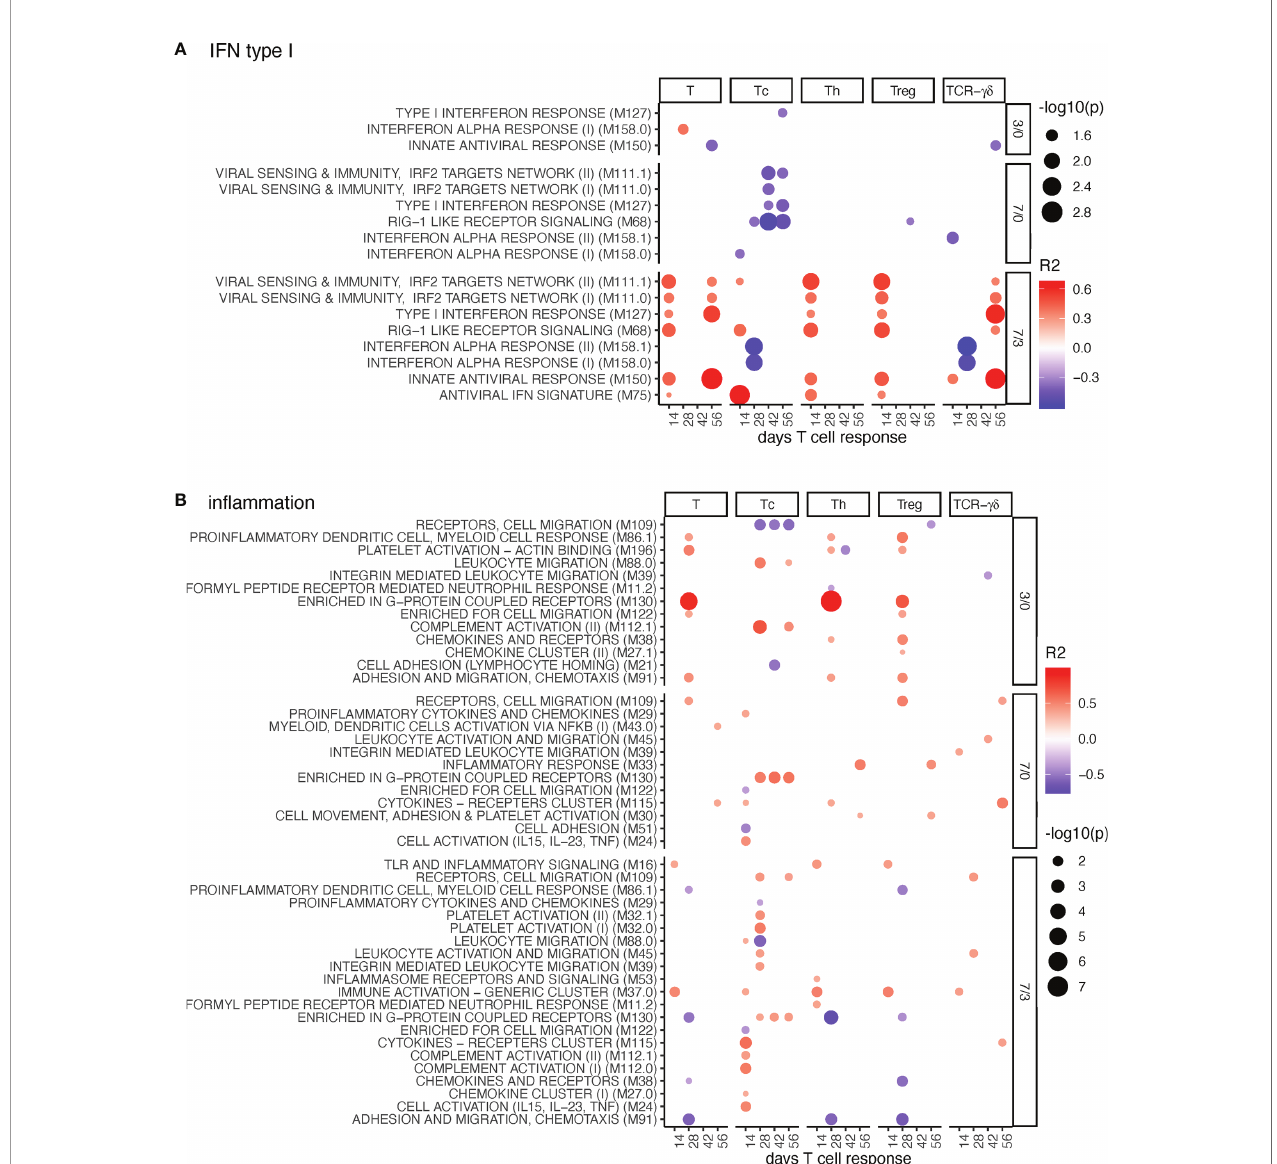
FIGURE 3 | IFN-I and in fl ammation BTM correlating with T-cell priming. Time-dependent single-sample enrichment scores for BTM were correlated with the proliferative recall response of total CD3 + T cells, Tc, Th, and TCR- gd T-cells measured at 14, 28, 42, and 56 days after LP or HP PRRSV-2 infection [x-axis, data from (15)]. R squared correlation coef fi cients for the BTM changes from D3/0, D7/0, and D7/3 are indicated by the color gradient (red for positive values, blue for negative values). Increased circle sizes indicate smaller p values (cutoff < 0.05). (A) shows IFN-I BTM and (B) in fl ammation BTM families